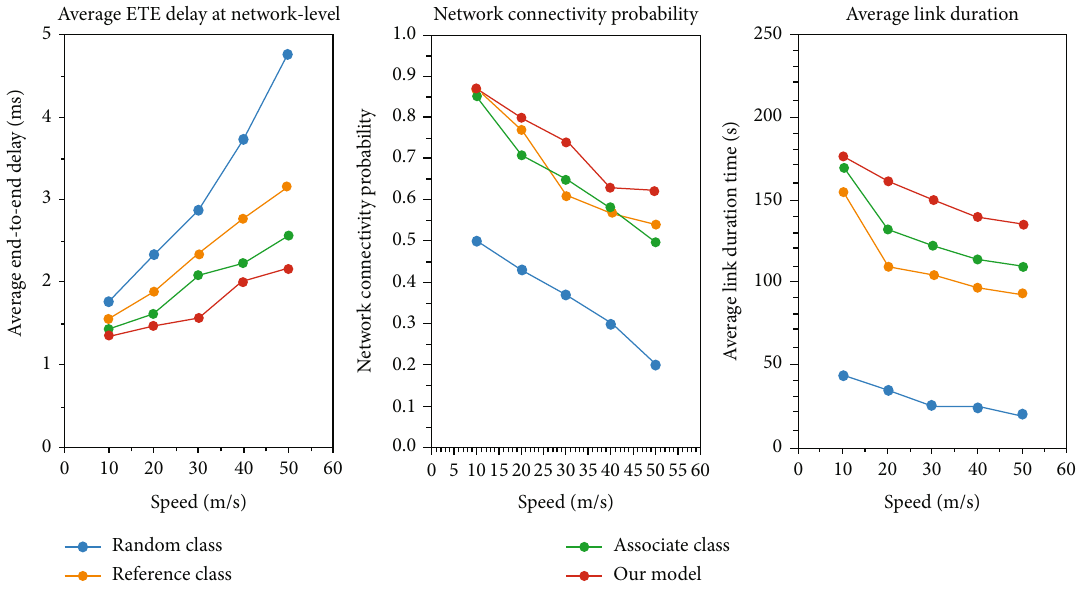
Figure 10: Basic performance evaluation with di ff erent velocities.